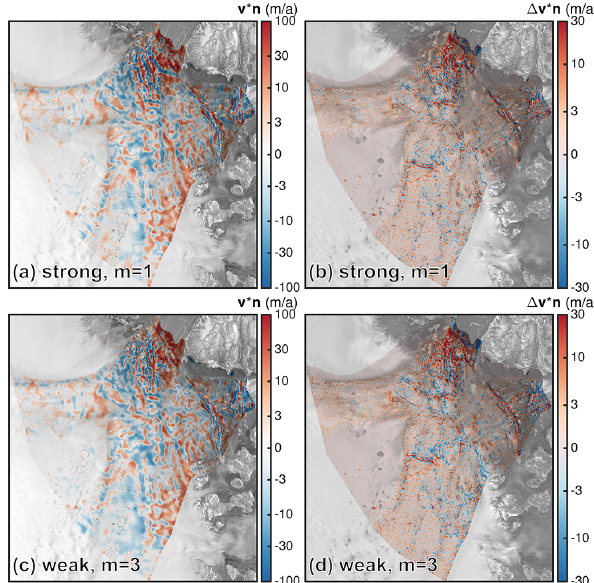
Figure 10. Evaluation of the kinematic boundary condition (emer- gence velocity v · n ) at the surface for l = 150m. Surface mass bal- ance is assumed to be zero. The upper row shows (a) FS emer- gence velocity and (b) emergence velocity differences between FS and BP-like ( v · n | FS − v · n | BP − like ) for m = 1 and P1P1GLS strong. Panels (c) and (d) show the equivalent fields for m = 3 and P1P1GLS weak. Background image is a RADARSAT Mosaic (Joughin, 2015; Joughin et al.,